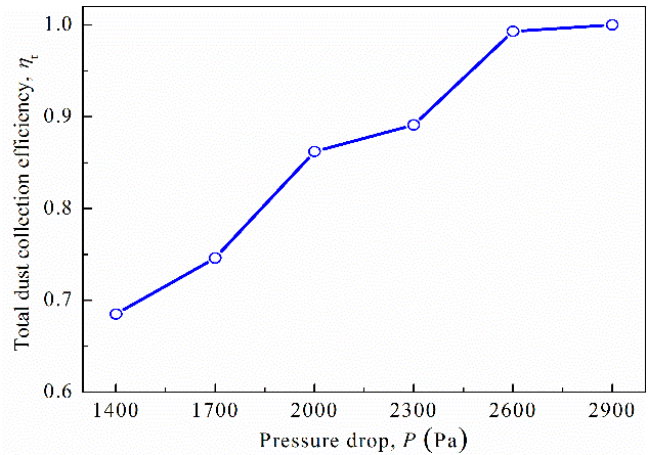
Figure 9. Influence of pressure drop on the separation efficiency.